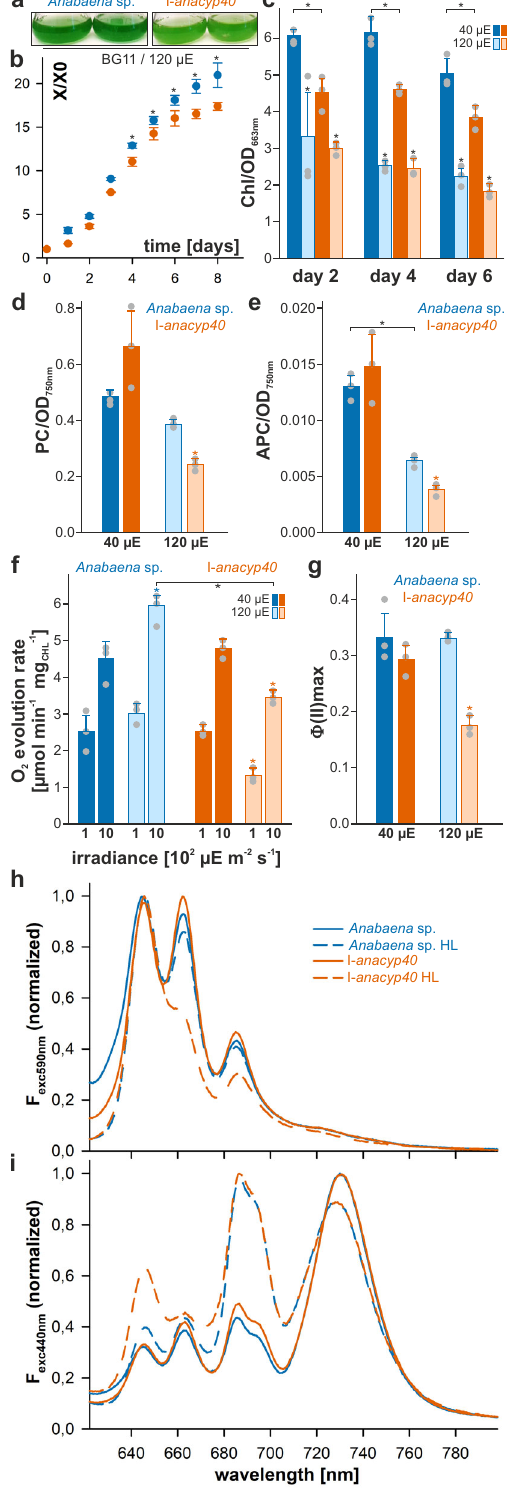
well as in a somewhat smaller peak at ~685 nm likely representing the fl uorescence of ApcE (~680 nm) and PSII (~685 – 695 nm) 47 – 50 . The shoulder at ~720 – 740 nm is related to the fl uorescence of PSI. wild-type strain was not observed (Fig. 3h, solid lines). When grown under high light, especially the allophycocyanin and the PSII fl uorescence was reduced in the mutant, while this fl uorescence was only moderately affected in wild type (Fig. 3h, dashed lines).